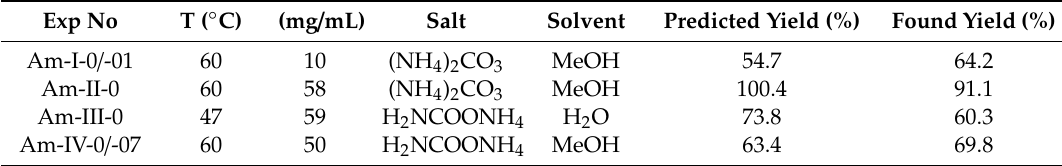
Table 2. Optimized reaction conditions and yields generated by